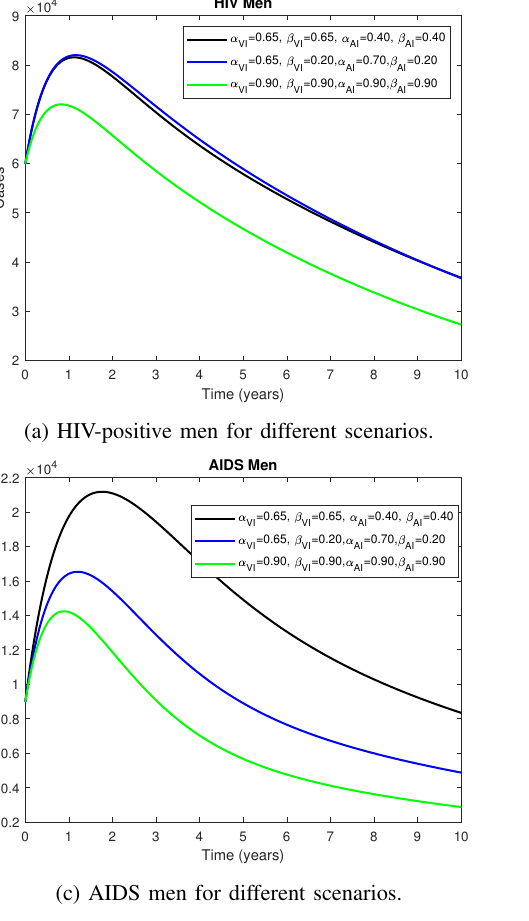
VI =0.90, VI =0.90, AI =0.90, AI =0.90